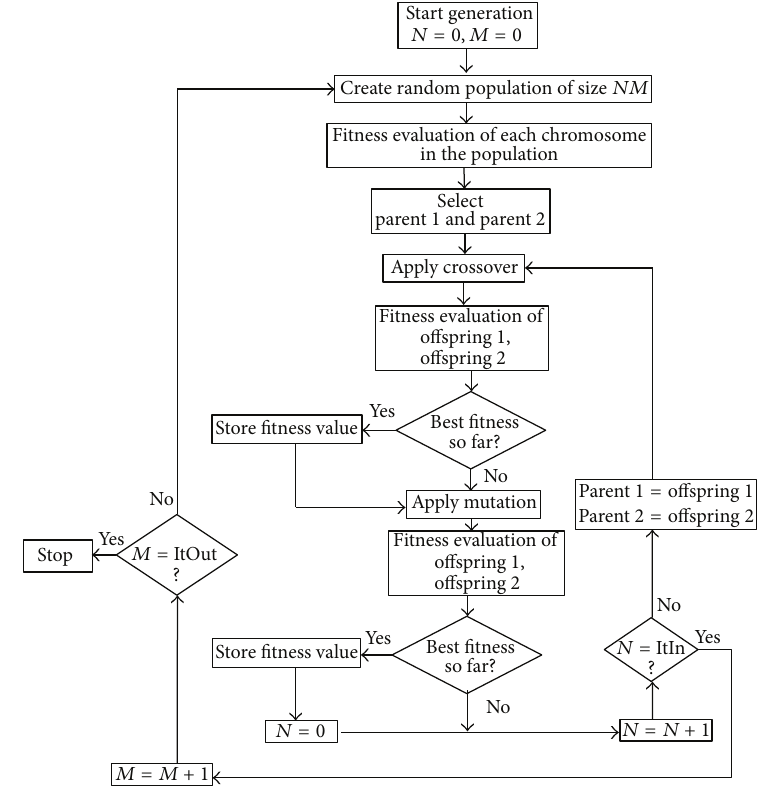
Figure 10: The flow chart of genetic algorithm operation.